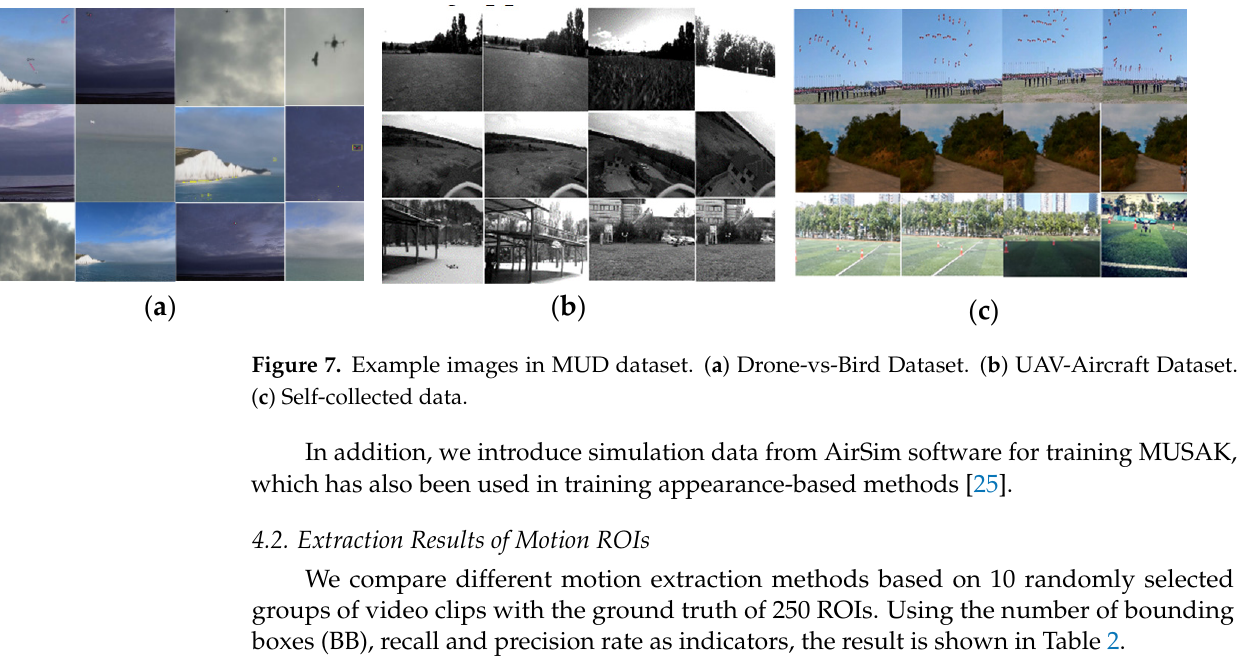
Table 2. Comparison of different ROI extraction methods.